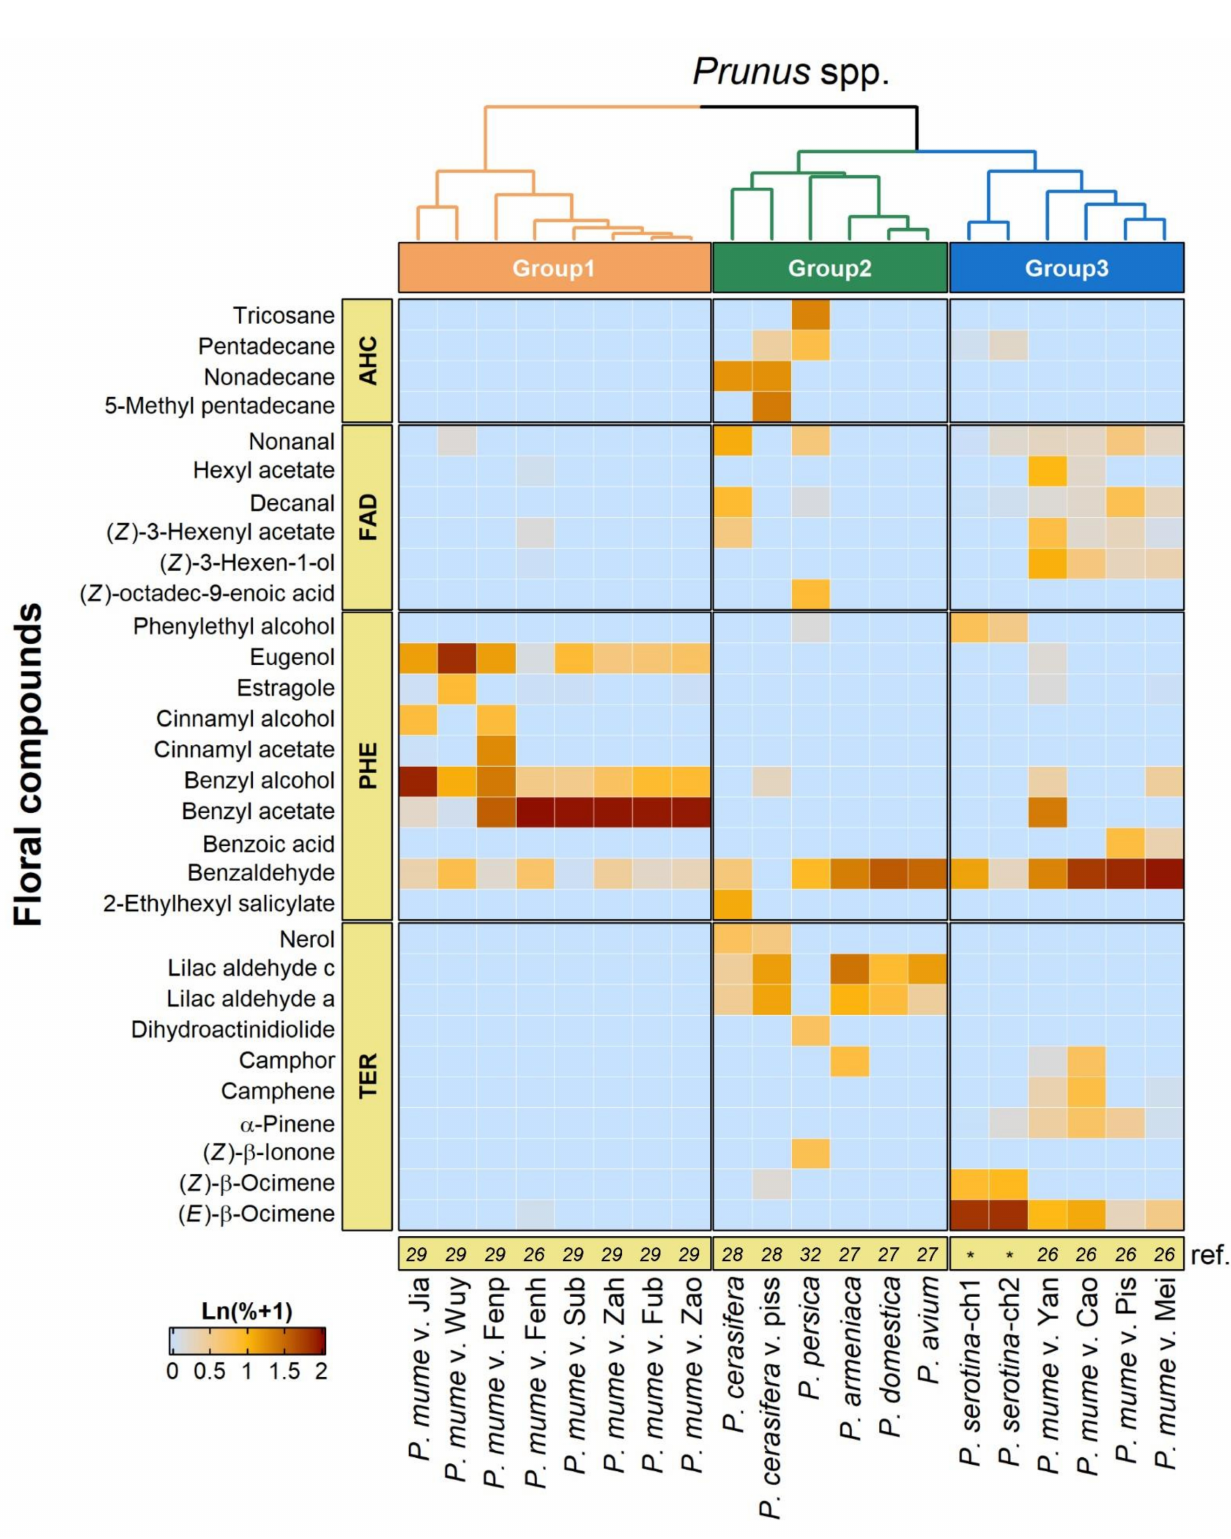
Figure 6. Heatmap and hierarchical clusters (groups 1–3) based on profiles of major floral volatile compounds in Prunus serotina and other Prunus species. Relative abundances (%) of volatile compounds were normalized by a shifted-log transformation, i.e., Ln (% + 1). Prunus species and cultivars were hierarchically clustered by Ward’s minimum variance method on Euclidean distances. Classes of floral volatile compounds: TER, terpenes and derivatives; PHE, phenyl- propanoids/benzenoids; FAD, fatty acid derivatives; AHC, alkane and alkene hydrocarbons. * data reported in this